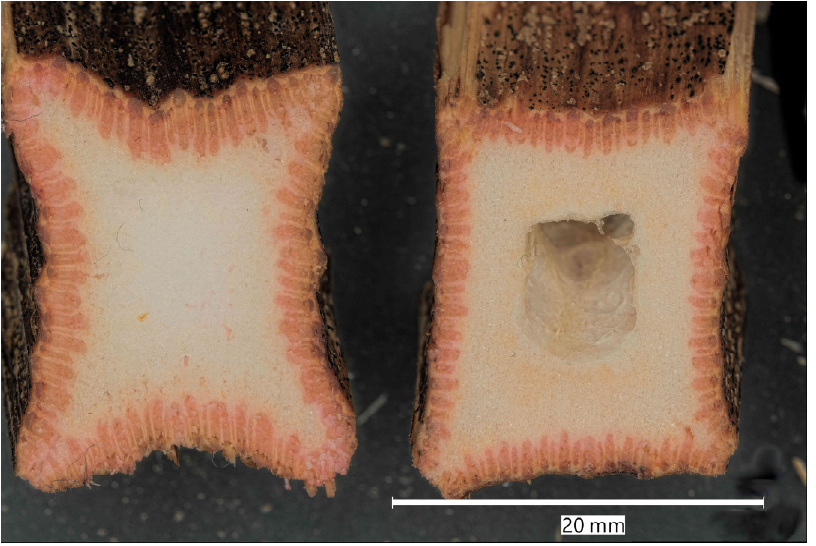
Figure 3. Cross-sections of commercial cup plant stems with visible parenchyma and cortex, Wiesner staining of the lignified cortex, under 20× magnification [image scalebar= 20 mm]. As all cup plants, the shoots, from the N.L. Chrestensen plots display a decreasing stem diameter at increasing stem heights. The stem diameter decreases up to 53% from the bottom to top. The absolute gravimetric amount of parenchyma decreases to 38% as shown in Table 2. Due to the low parenchyma density an approximately tenfold amount of cortex is observed. The high standard deviation of stem width and mass is likely caused by the phenotypic variation of the N.L. Chrestensen genotypes. Due to the fact, that the accessions. Table 2. Biomass qualities of commercially available cup plant material (N.L. Chrestensen) at three different stem heights [ n = 32].